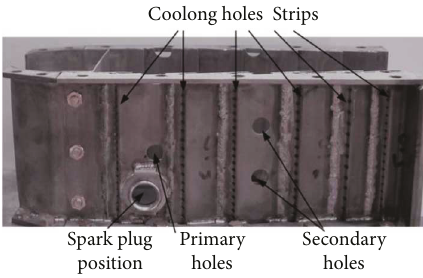
Figure 6: Geometry of the combustion chamber fl ame tube.